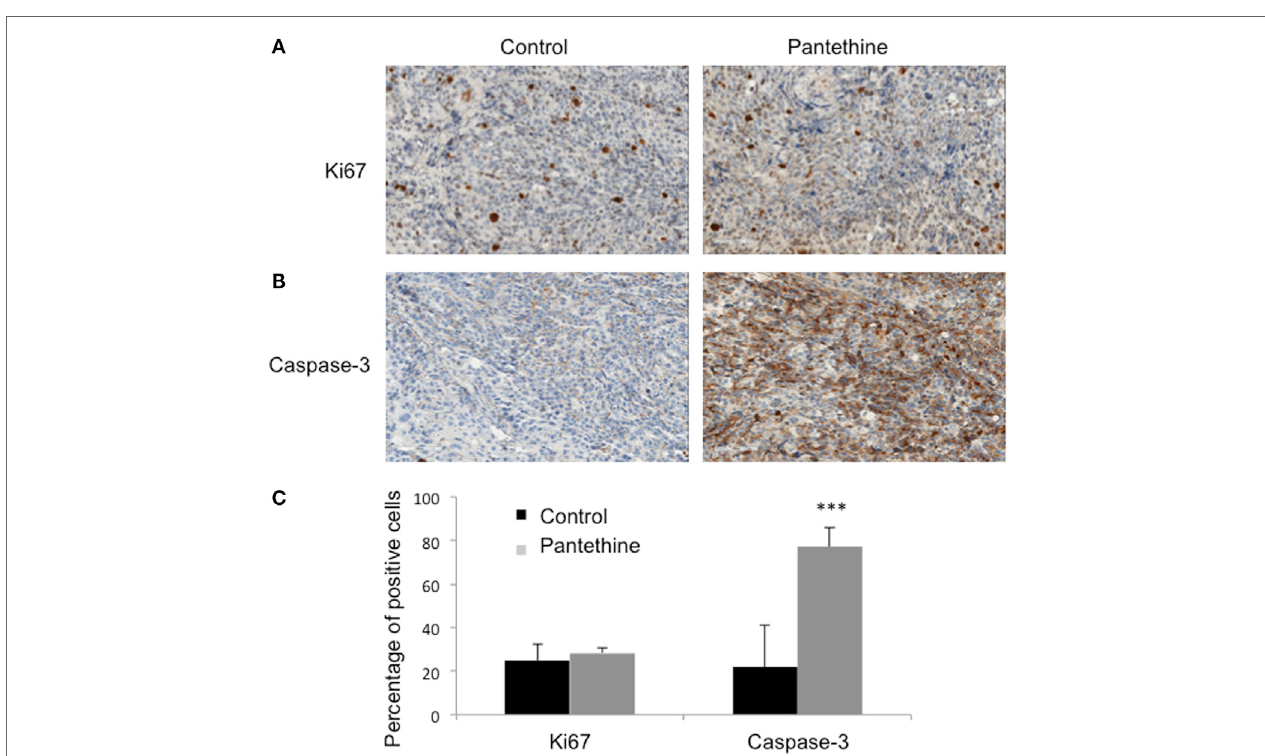
FigUre 4 | representative ihc stained sections of control and treated tumors for Ki-67 (a) and caspase-3 (b) . (c) Histogram representing the percentage of positive cells for each marker in control and treated tumors ( n = 3; mean ± SD are represented; *** P <